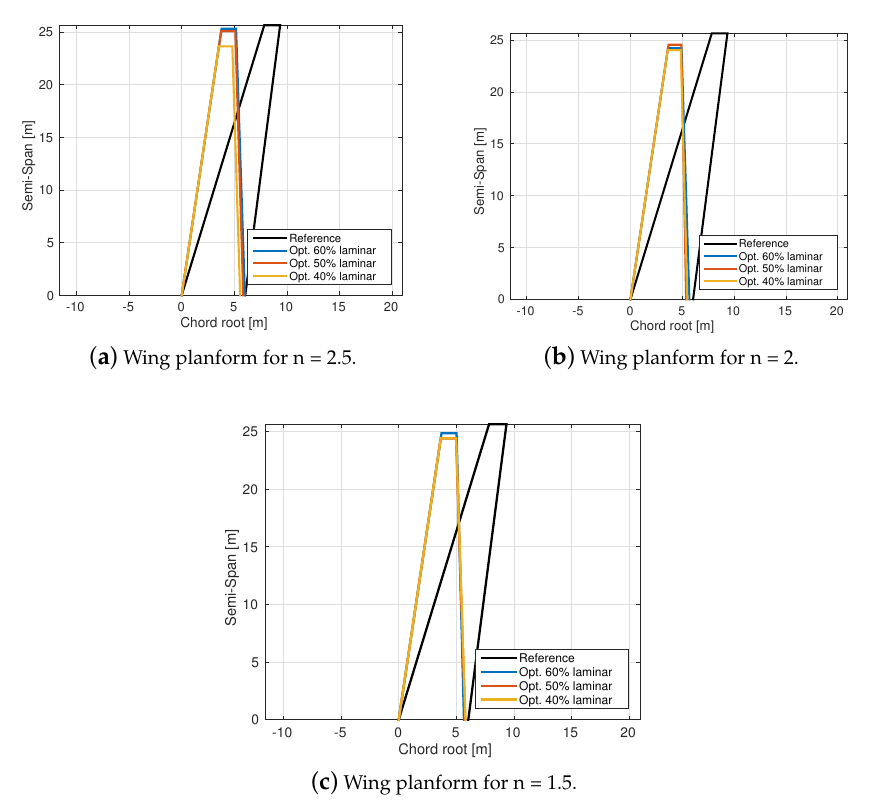
Figure 15. Backward-swept wing geometry at different load factor and portion of laminar flow.